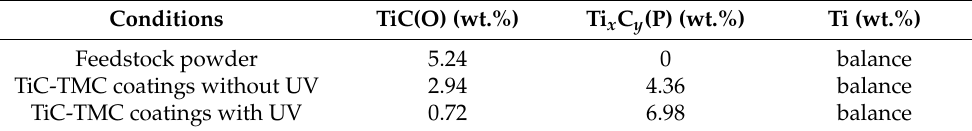
Table 2. Phase compositions of the feedstock powder and the TiC-TMC coatings with 5% TiC. Conditions TiC(O) (wt.%) Ti x C y (P) (wt.%) Ti (wt.%) Feedstock powder